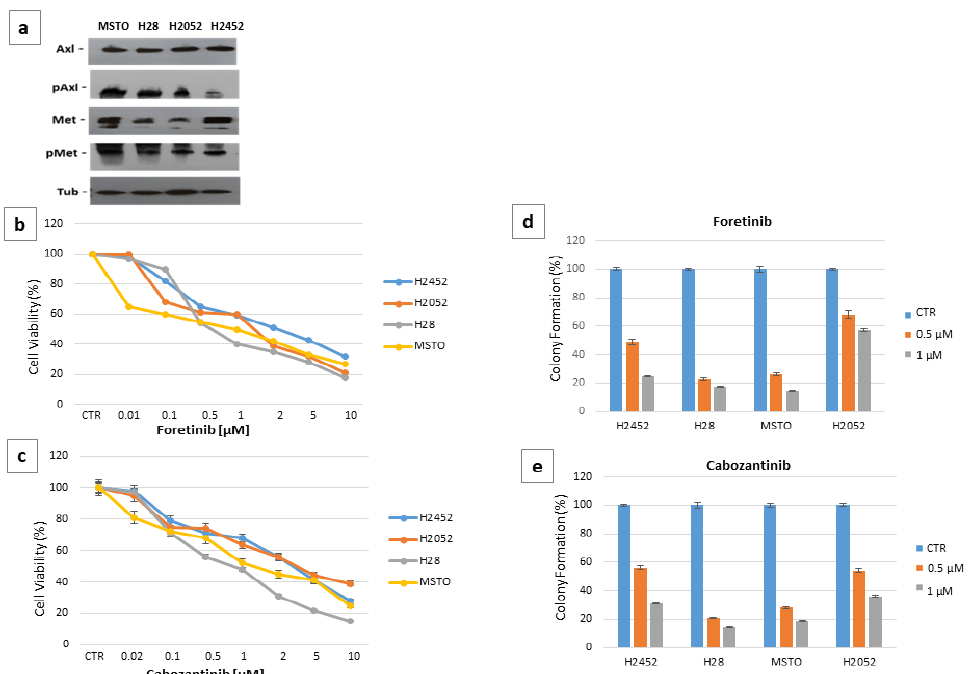
Figure 3. Representative in vitro results of the treatment of human mesothelioma cell lines with increasing doses of the AXL-MET specific inhibitors. ( a ) Western blot analysis for AXL, phospho- AXL, MET, phospho-MET were performed on protein lysates from MISTO, H28, H2052 and H2452 mesothelioma cell lines. α -Tubulin was included as a loading control. ( b ) effect of foretinb on the proliferation of mesothelioma cell lines, 72 h treatment; ( c ) effect of cabozantinib on the proliferation of mesothelioma cell lines, 72 h treatment; ( d ) colony forming abilities of mesothelioma cell lines after the treatment with foretinib; ( e ) colony forming abilities of mesothelioma cell lines after the treatment with cabozantinib. H2452: epitheliod mesothelioma cell lines, H28: sarcomatoid mesothelioma cell lines, MSTO: biphasic mesothelioma cell lines, H205: epithelioid meso- thelioma cell lines.